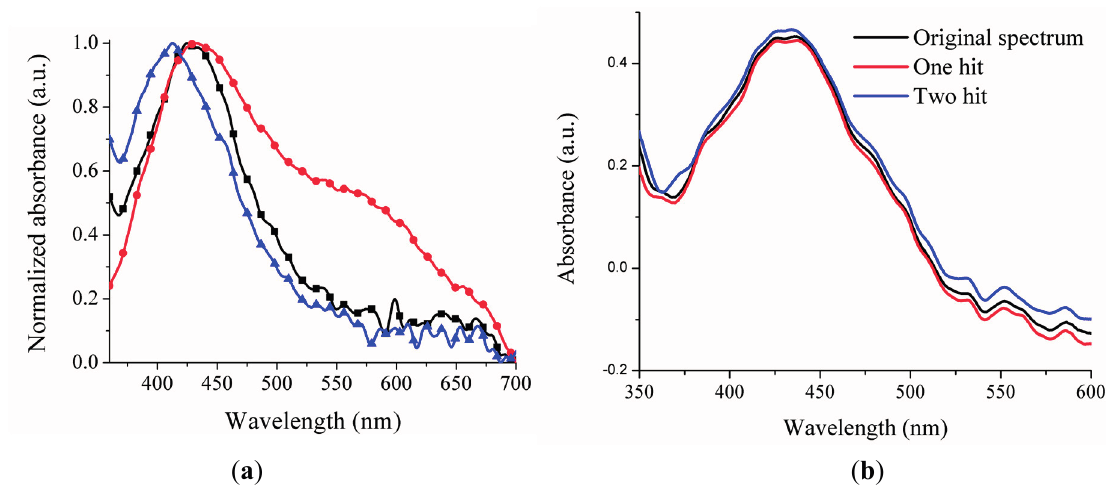
Figure 5. Sensor response based on LSPR localized in air. ( a ) The nanoparticles were photodeposited on the optical fiber end with the same conditions; ( b ) Sensor response before and after hitting the optical fiber.